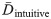
A comparison of the two entropy-based distance metrics showing that the intuitive divergence D¯intuitive lies below the Jensen-Shannon measure D¯JS (each point corresponds to one pair of movies).